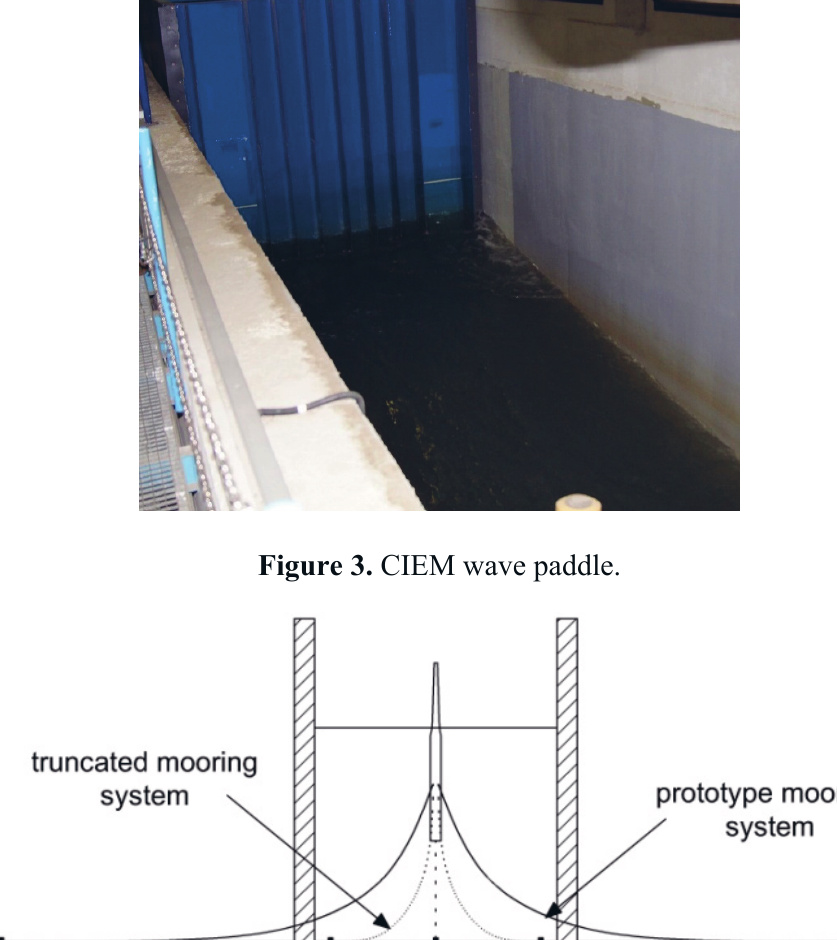
Figure 4. Prototype vs. truncated mooring